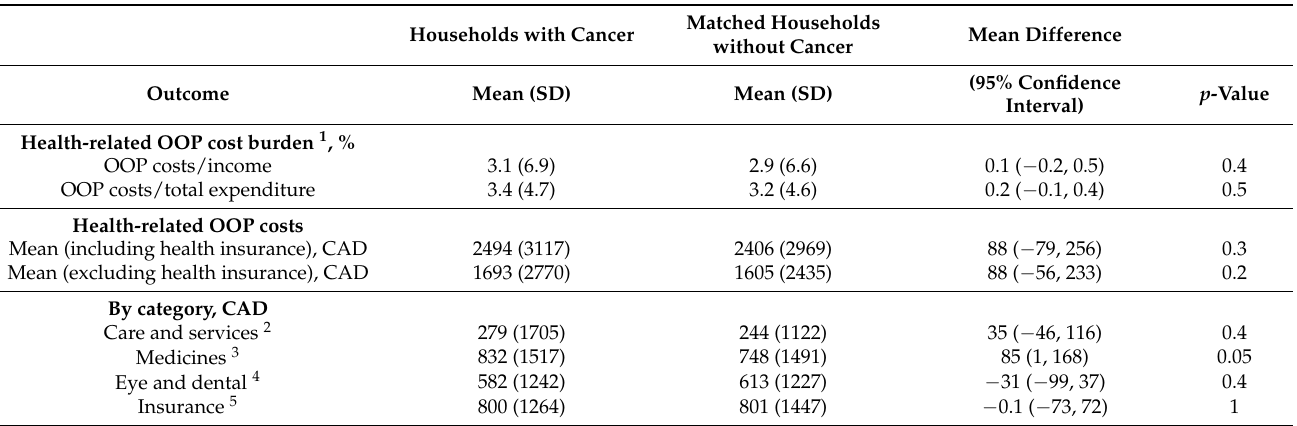
Table 4. Health-related out-of-pocket cost burden, household expenditure and 12-month out-of- pocket expenditures of households with and without cancer.